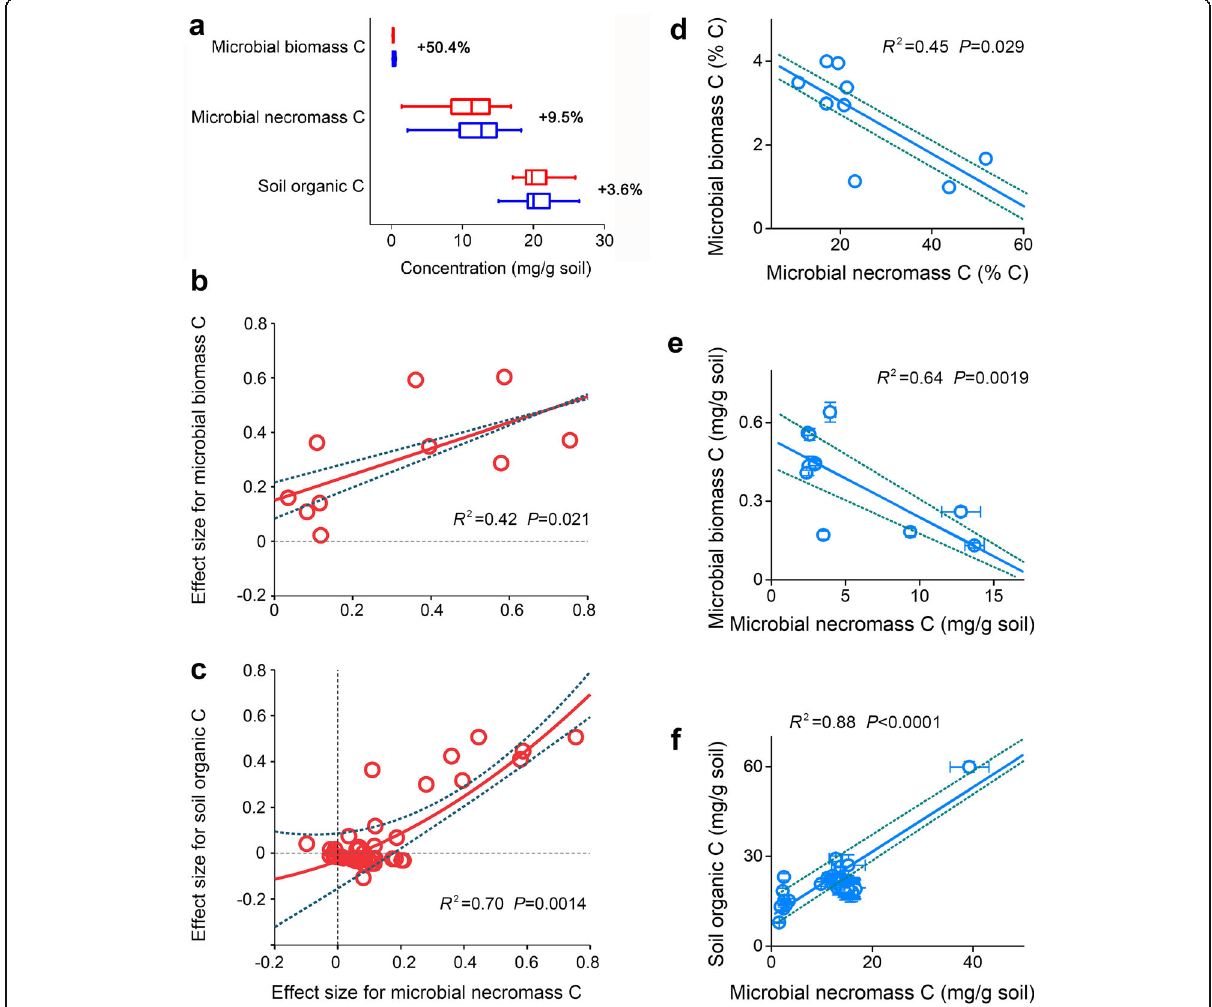
Fig. 3 a Average concentrations of microbial biomass C, microbial necromass C, and soil organic C at control (red) and N addition (blue) plots across the studied sites. The box plots show the median and 25th and 75th percentiles. The values show percent changes in microbial biomass C, microbial necromass C, and soil organic C under N addition. All these variables were collected at the control and N addition plots at the 11 sites at which microbial necromass C data were obtained. Microbial biomass C values are presented on the basis of chloroform fumigation extraction analysis. b , c The effect sizes of N addition on microbial necromass C plotted against the effect sizes on microbial biomass C and soil organic C, respectively. d Proportions of microbial necromass C in soil organic C versus those of microbial biomass C in soil organic C. e , f The concentrations of microbial necromass C versus those of microbial biomass C and soil organic C, respectively. All data shown in panels d – f were collected at control plots, and error bars represent the standard errors. The dotted lines show the 95% confidence intervals, and the adjusted R 2 and P values are shown in all panels except panel